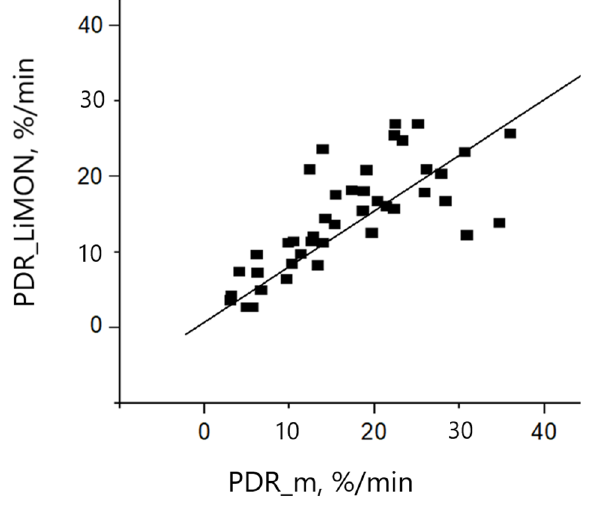
Figure 9. Comparison of PDR measurement by LiMON and our device.